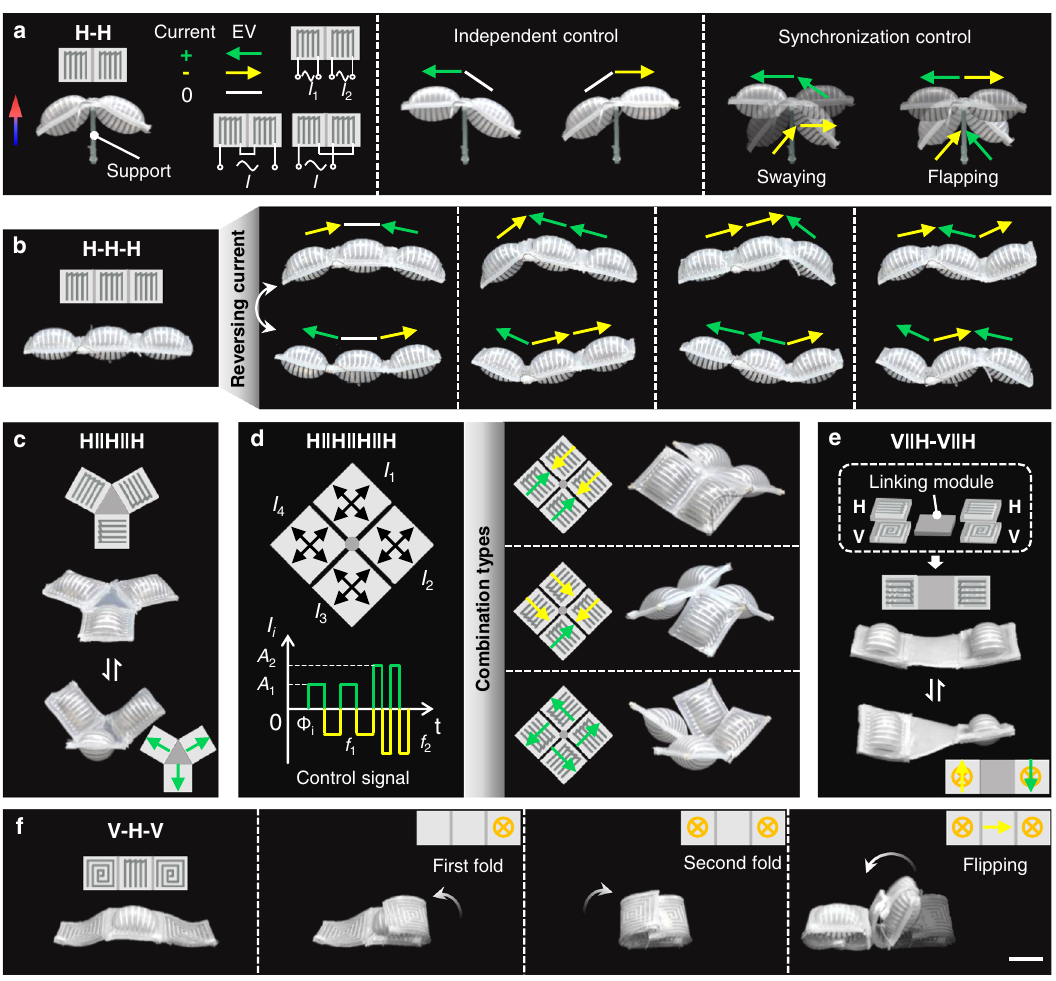
Fig. 5 | Reprogrammable shape morphing of SESRs by self-vectoring control. a Independent and synchronizationcontrolofa symmetric H-H structure. Thetwo modules can be controlled separately by two independent signals or by one signal astheirLMcoils can beconnectedtogetherin series (either head-to-head or head- to-tail). b H-H-H, a strip structure assembled by three H modules in series. c H||H||H, a triangle structure assembled by three H modules in parallel using